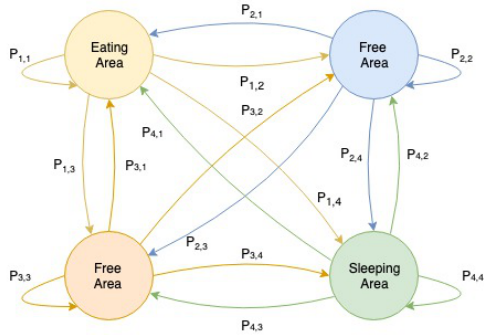
Figure 10. Markov chain for animal